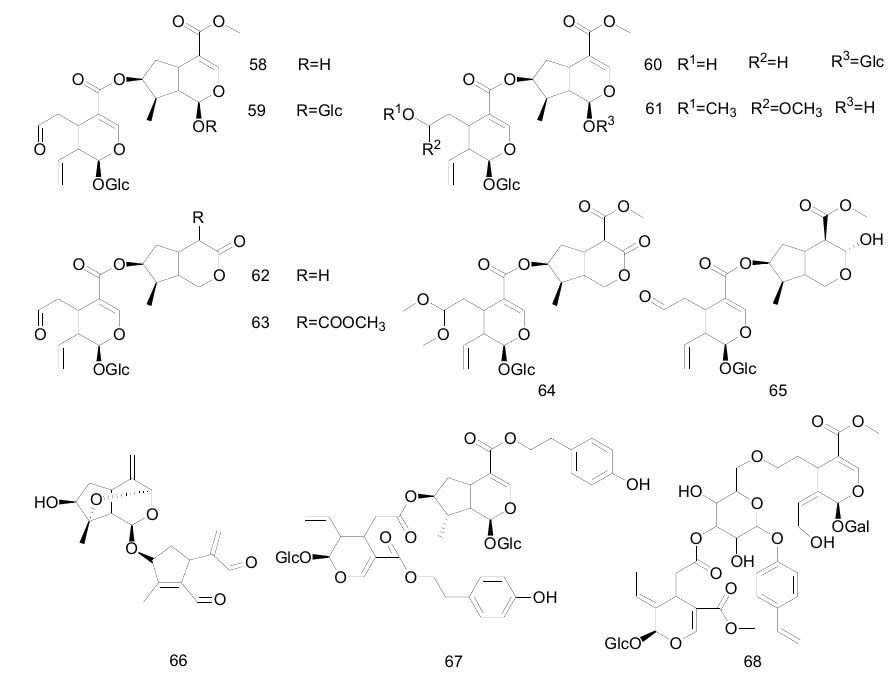
Figure 4. Chemical structures of bis-iridoids.